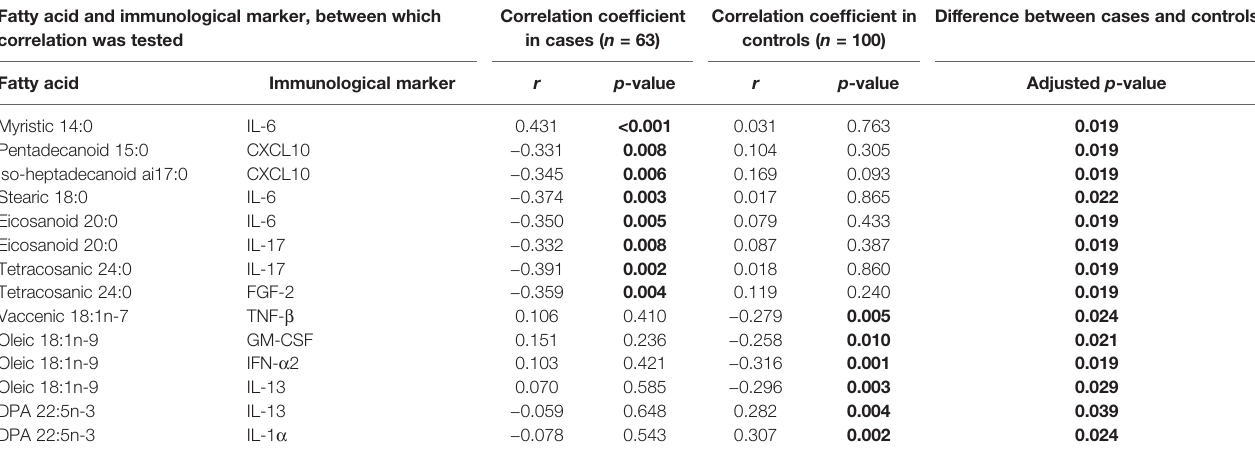
The table includes all the correlation coef fi cients that were signi fi cant for cases or controls (p < 0.01) and different between them using Fisher ’ s r to z-transformation for Spearman correlation and z-test (p < 0.05) and p-values were further adjusted with the Benjamini – Hochberg method. Signi fi cant p-values are bolded.